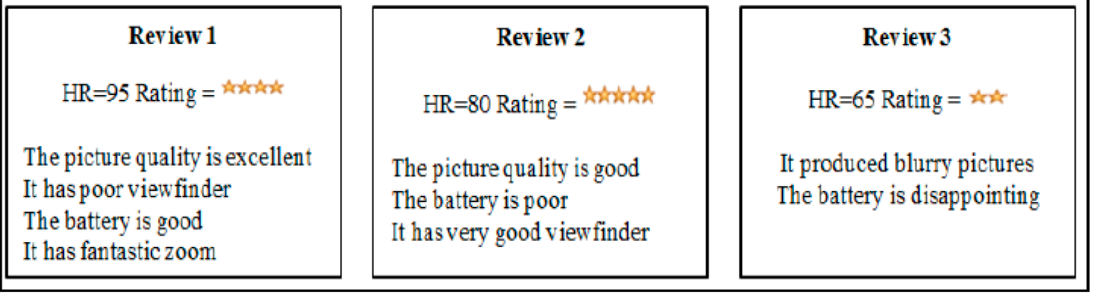
Figure 4. Example reviews.